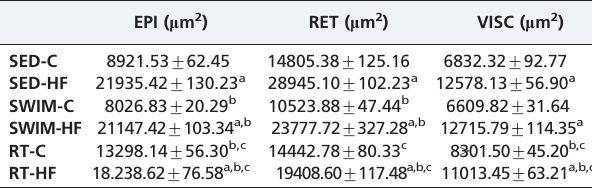
Table 2 - Epididymal, retroperitoneal and visceral adipocyte